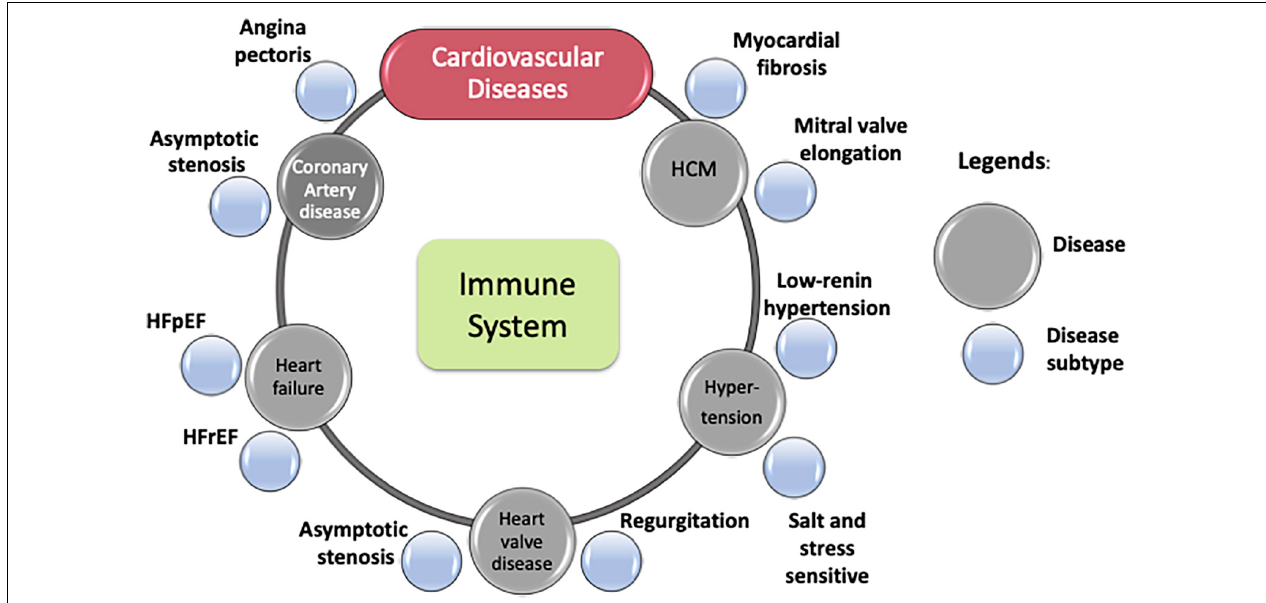
FIGURE 1 | Cardiovascular diseases and some of their subtypes. Immune process lies at the core of most cardiovascular